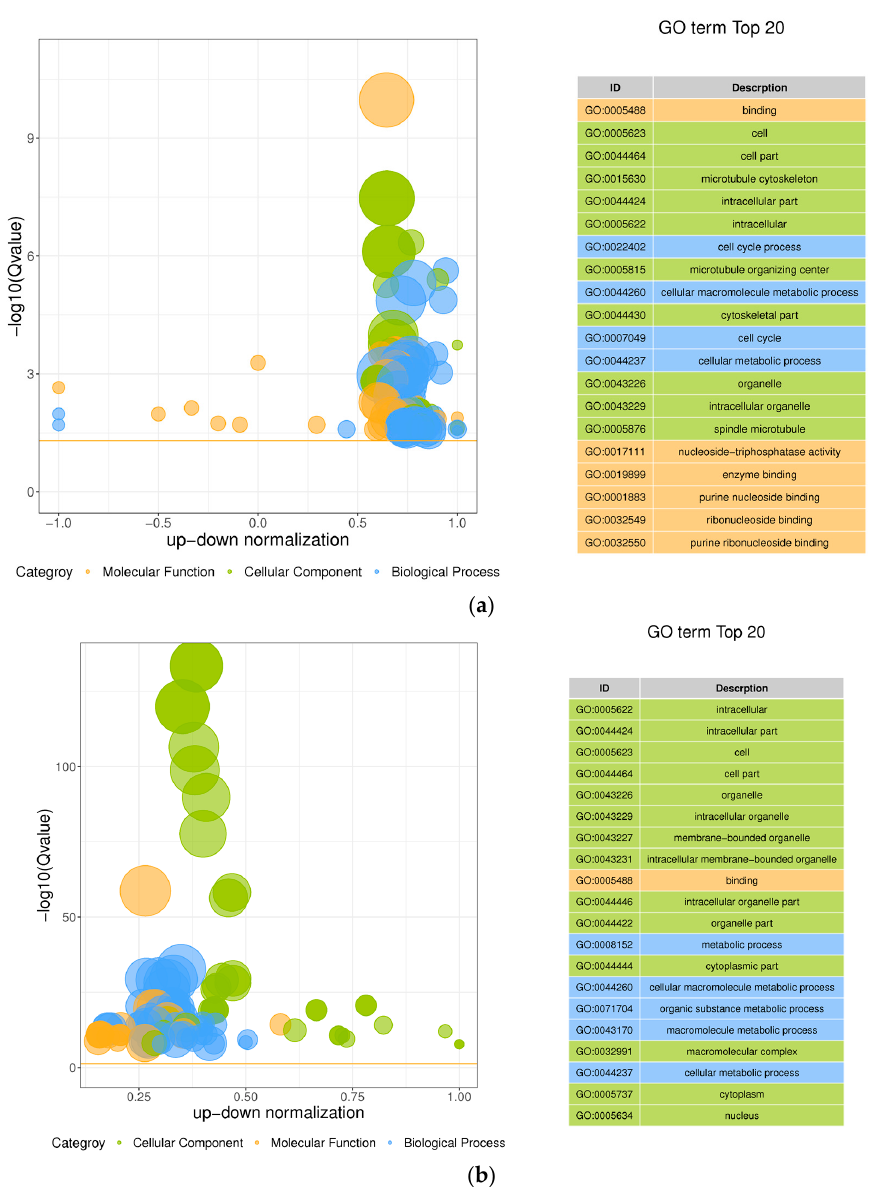
Figure 5. The GO enrichment bubble diagram of difference. ( a ) siRNA − MSTRG.16919.1